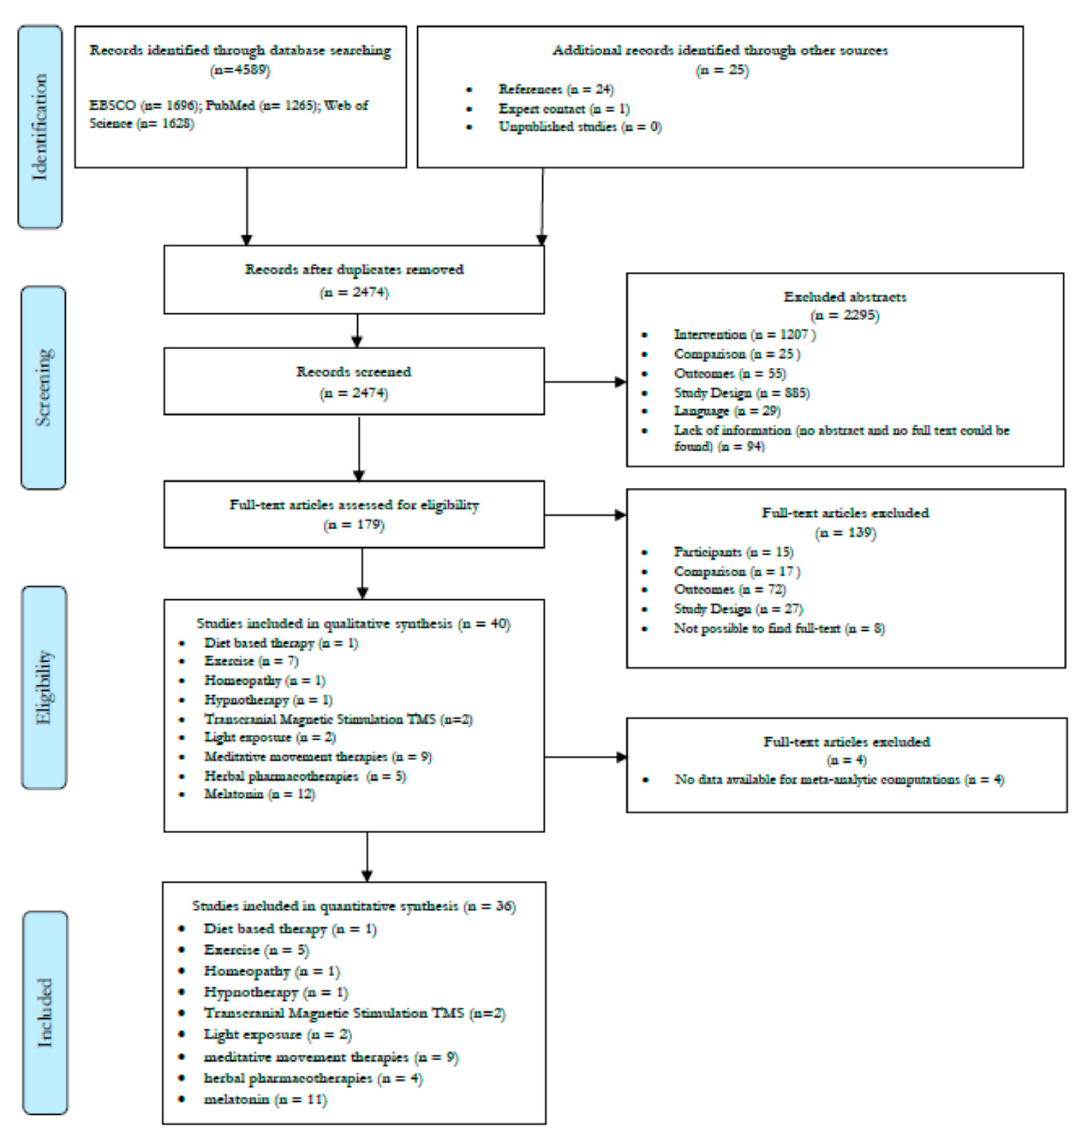
Figure 1. Search flow.